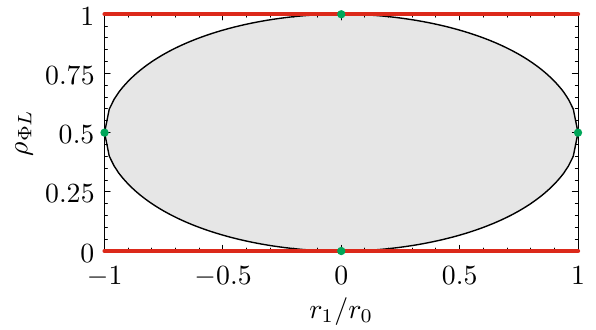
Fig. 1 Orbit space relation between ρ Φ L and r 1 / r 0 . A similar param- eter space is available for ρ Φ R vs. r 1 / r 0 . Considering the green points yields simplest necessary conditions and considering the red lines suf- ficient conditions for vacuum